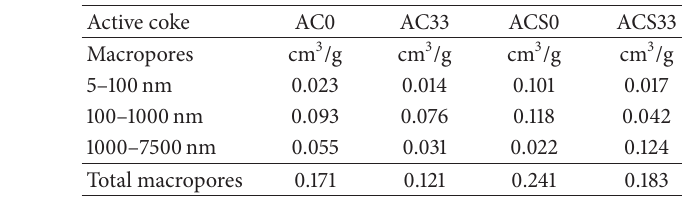
Table 2: Macroporosity of fresh and used active cokes.